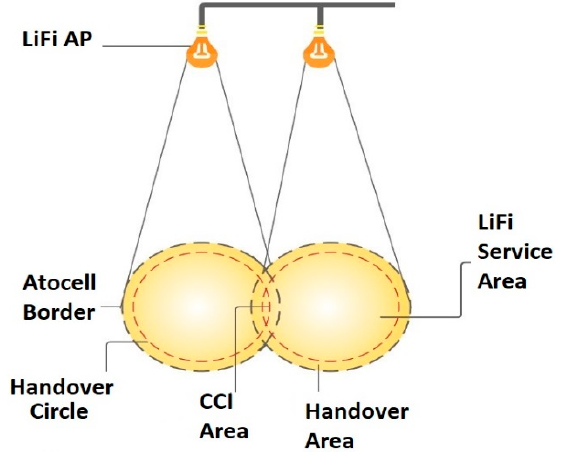
Figure 5. LiFi attocell in